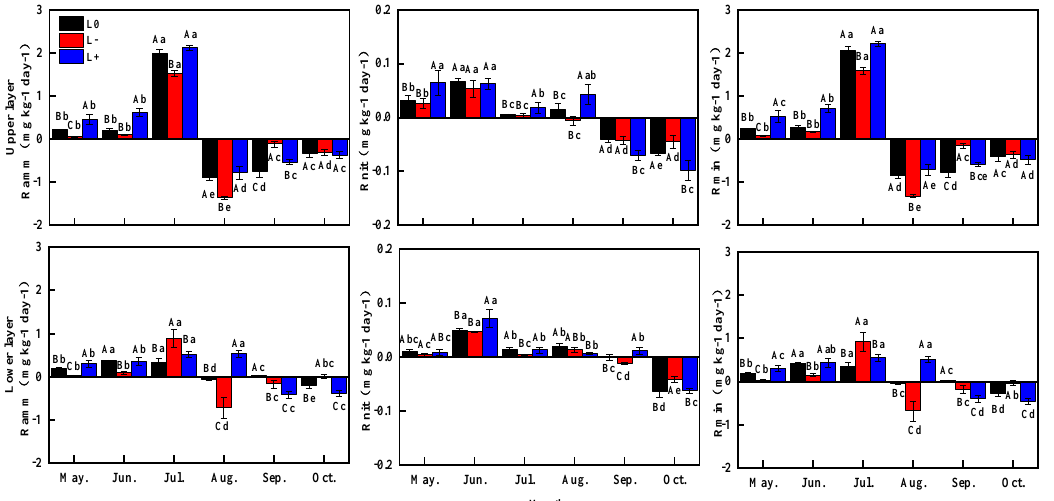
Figure 6. Monthly dynamics of the contents of soil net N mineralization of di ff erent litter manipulation in varied soil layers of the Larix gmelinii forest. Di ff erent capital letters indicate significant di ff erences between manipulations in each soil layer, and di ff erent lowercase letters indicate significant di ff erences among di ff erent months ( p < 0.05) ( n = 9). Table 4. Pearson correlation coe ffi cients (r) for soil characteristics and Rmin (rate of net mineralization) for L0, L − , and L +